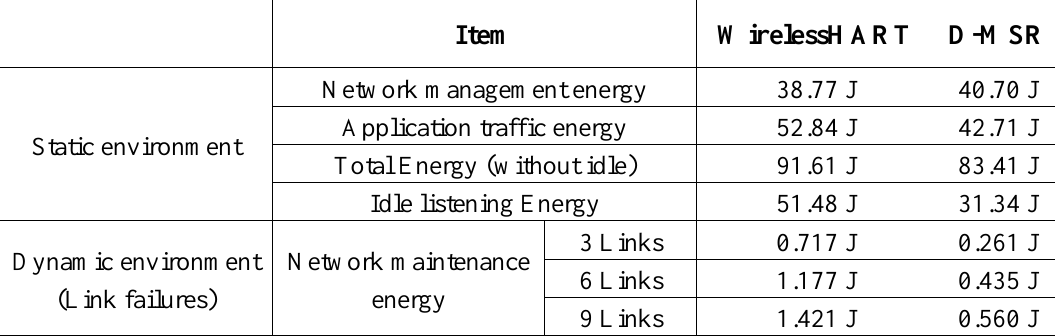
Table 8. Energy-consumption in the network (in 1,000 s) during normal